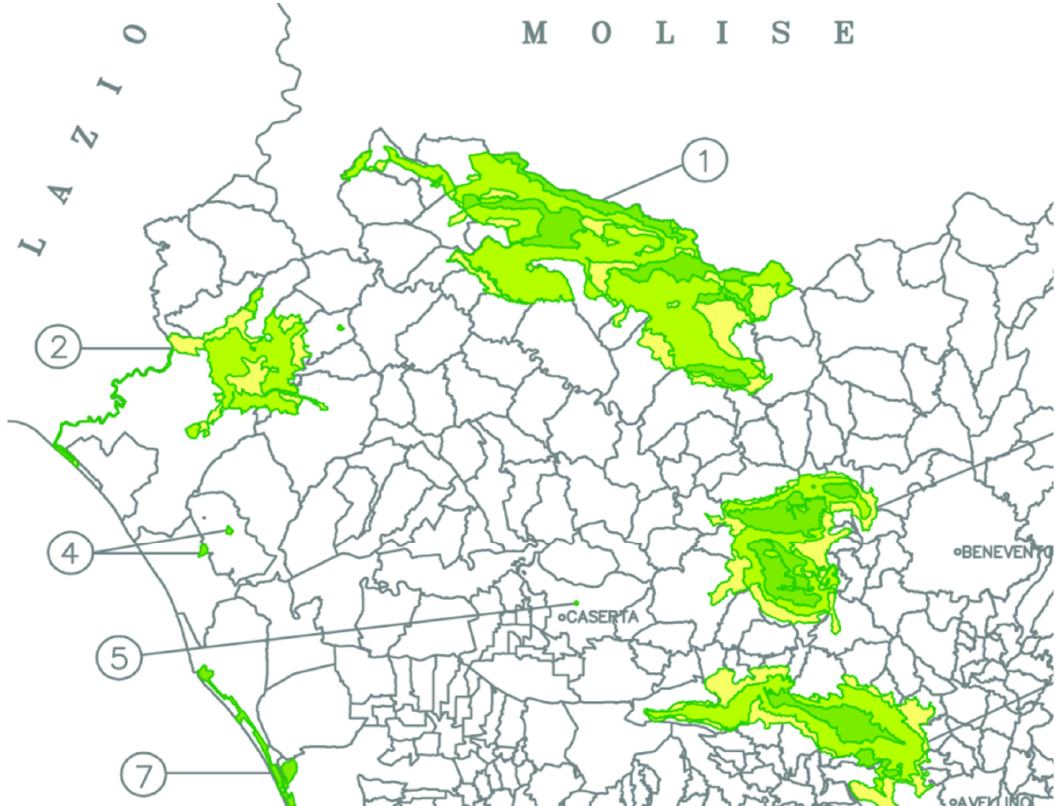
Figure 3. Map of protected natural areas in the Campania Region, northern section. No. 2 highlights